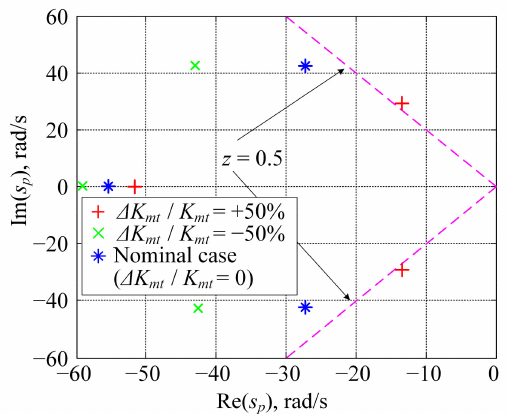
Figure 12. Dominant closed-loop pole locations of PID controller-based DC bus control system ICE speed control system subject to torque gain error.